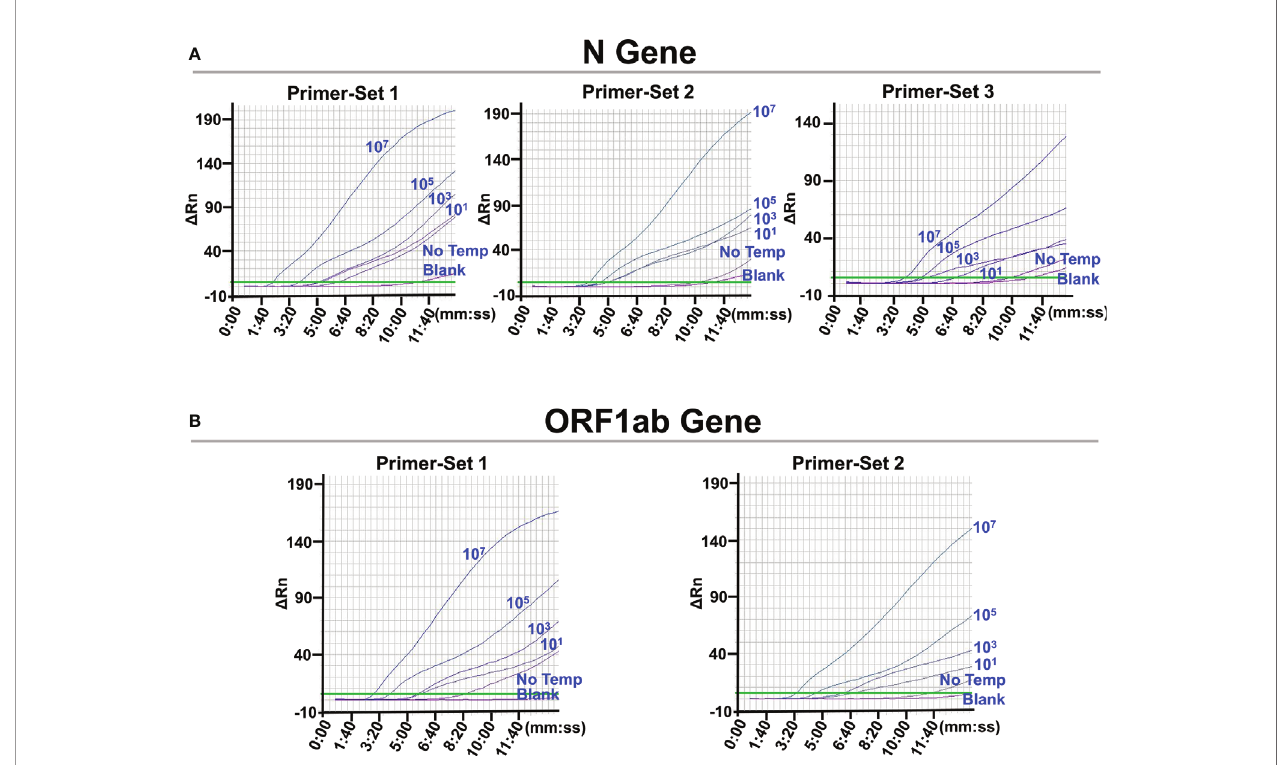
FIGURE 3 | Screening for optimal RPA primer sets. The images were the fl uorescence history diagrams of RPA ampli fi cations with different primer sets for the detection of N gene (A) and ORF1ab gene (B) . For RPA reactions using each primer set, the corresponding probe pairs were used for the preceding ligation reactions. The diagrams showed the fl uorescence signal ( D Rn) vs . time (mm:ss). The blue numbers beside the curves indicated the amount of RNA standard templates (in copies) used in the corresponding L/RPA assays. No Temp: the control with no RNA template. Blank: the control RPA reactions without the ligation reaction components and the RNA template. Every diagram was one typical outcome of three independent